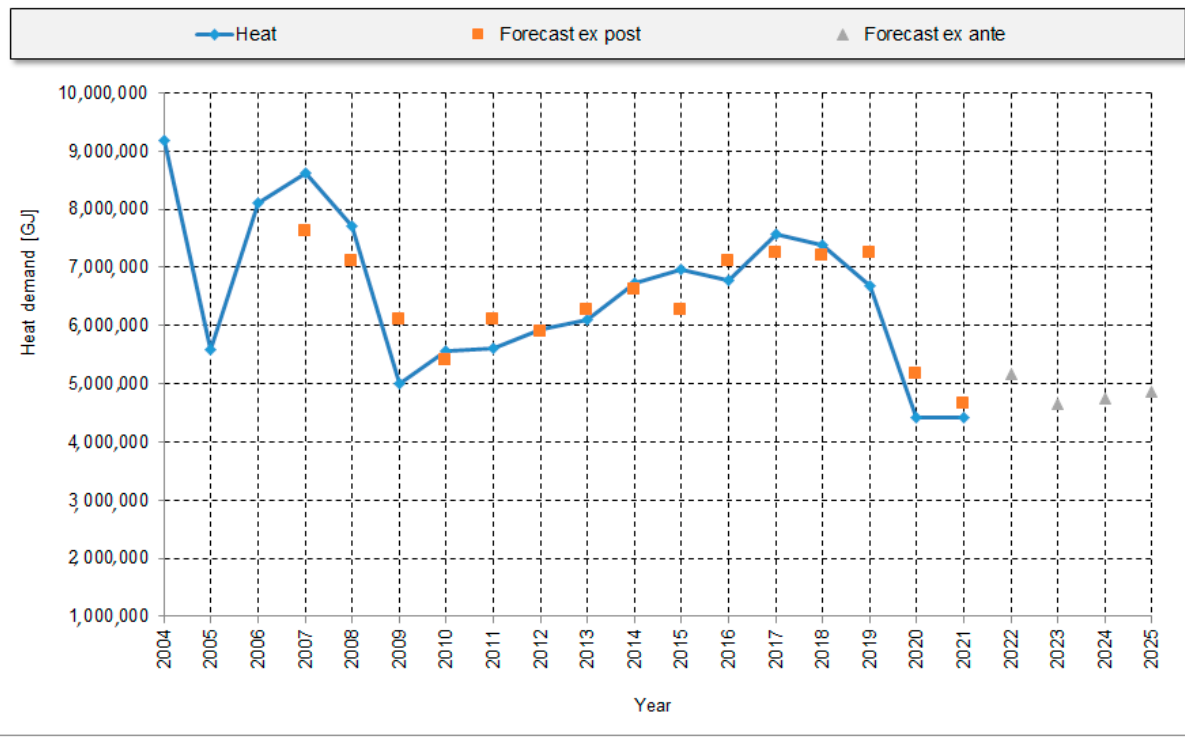
Figure 17. Forecasts of heat demand in steel industry in Poland.